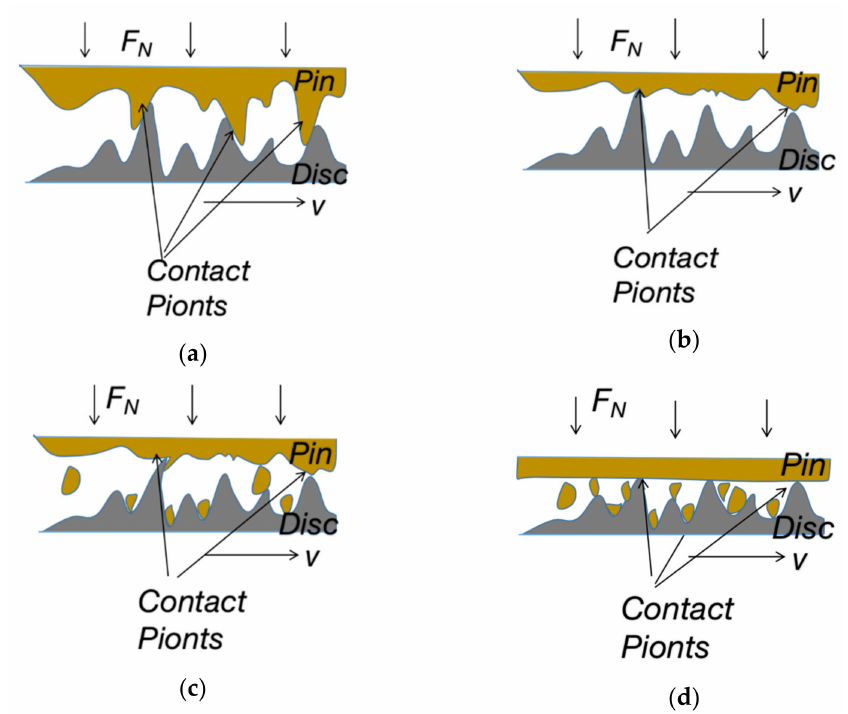
Figure 11. Schematic diagram of establishing the stable process for the friction coefficient under a low load of 15 N: ( a ) establishment contact; ( b ) ploughing; ( c ) generation of early wear debris; and ( d ) adhesion of wear debris. Table 5. Comparison on the performance of the present copper-steel tribo-pair with the results in literature. Tribo-Pair